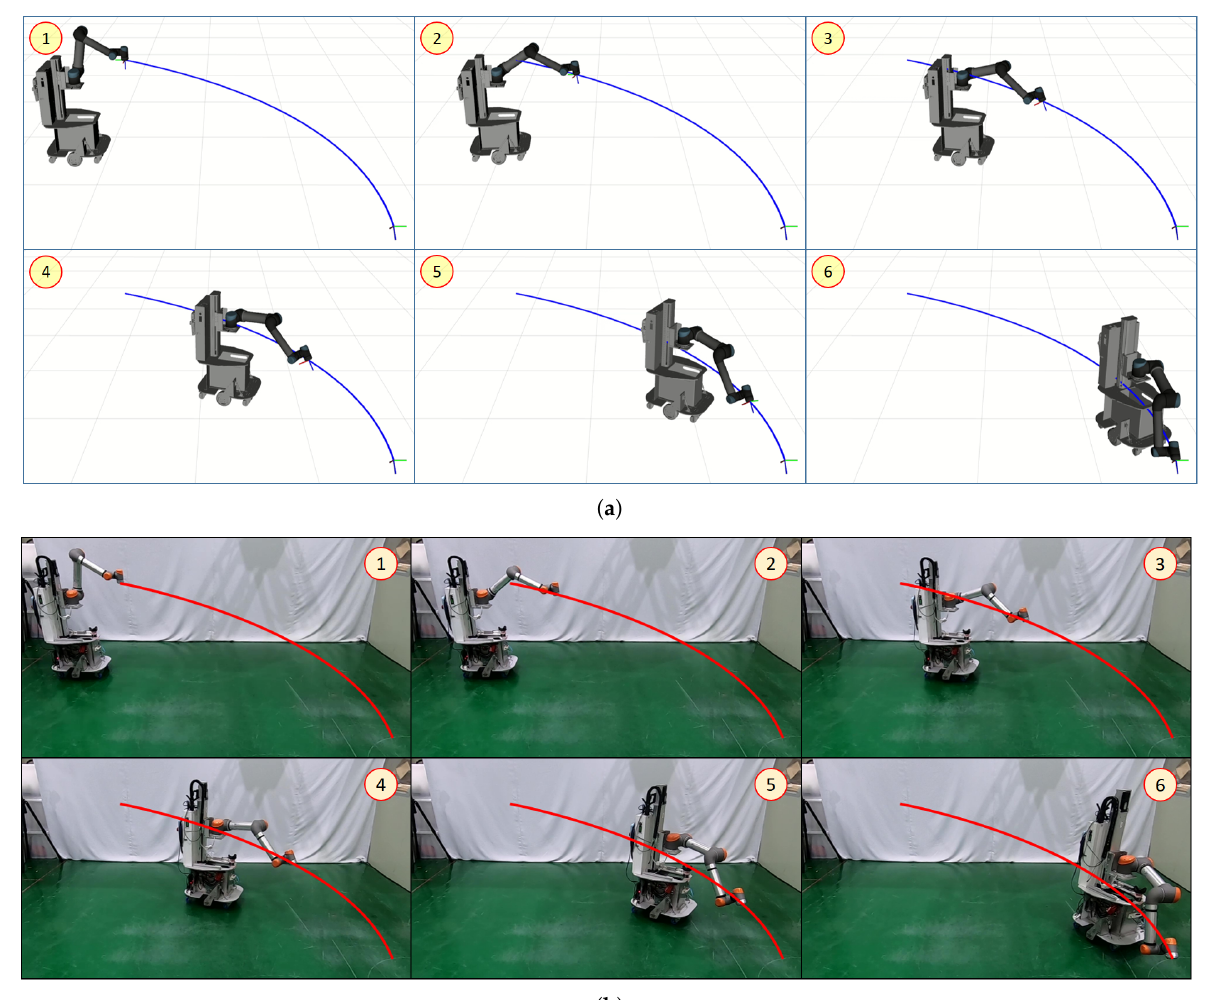
Figure 10. Snapshots of the NMM’s motion for the elliptic trajectory tracking: ( a ) simulations; and ( b )